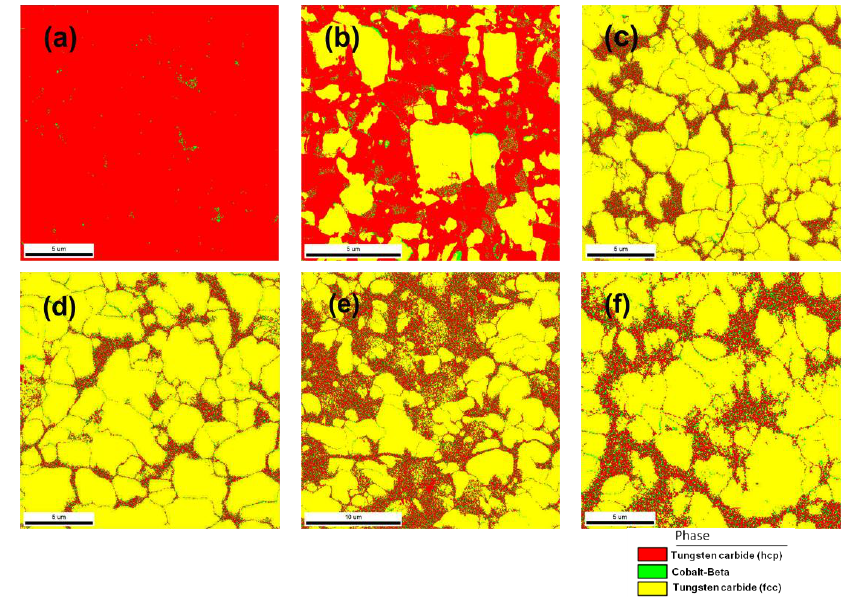
Figure 3. Phase maps on the surface of WC-6% Co hard alloy ( a ) before and ( b ) after HCPEB treatments with 1 pulse; ( c ) 5 pulses; ( d ) 10 pulses; ( e ) 20 pulses; and ( f ) 35 pulses. The scanning step was set at 30 nm.